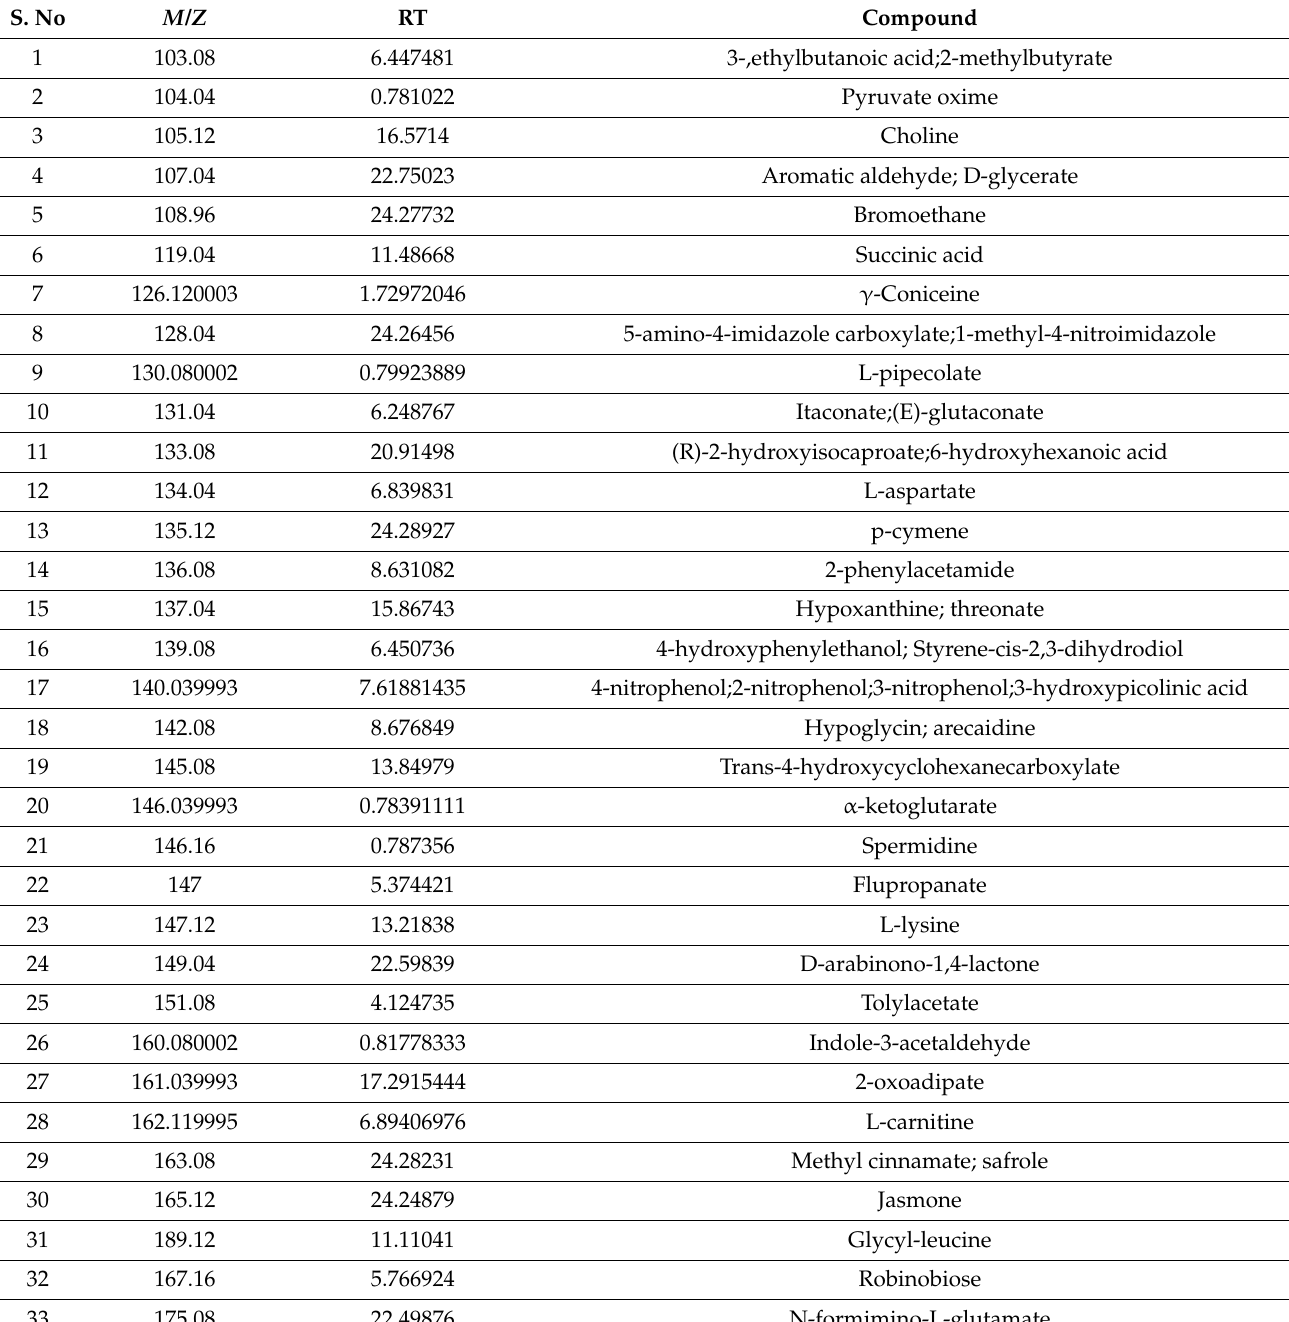
Table 1. Phytochemicals detected from the methanolic extract of TA by